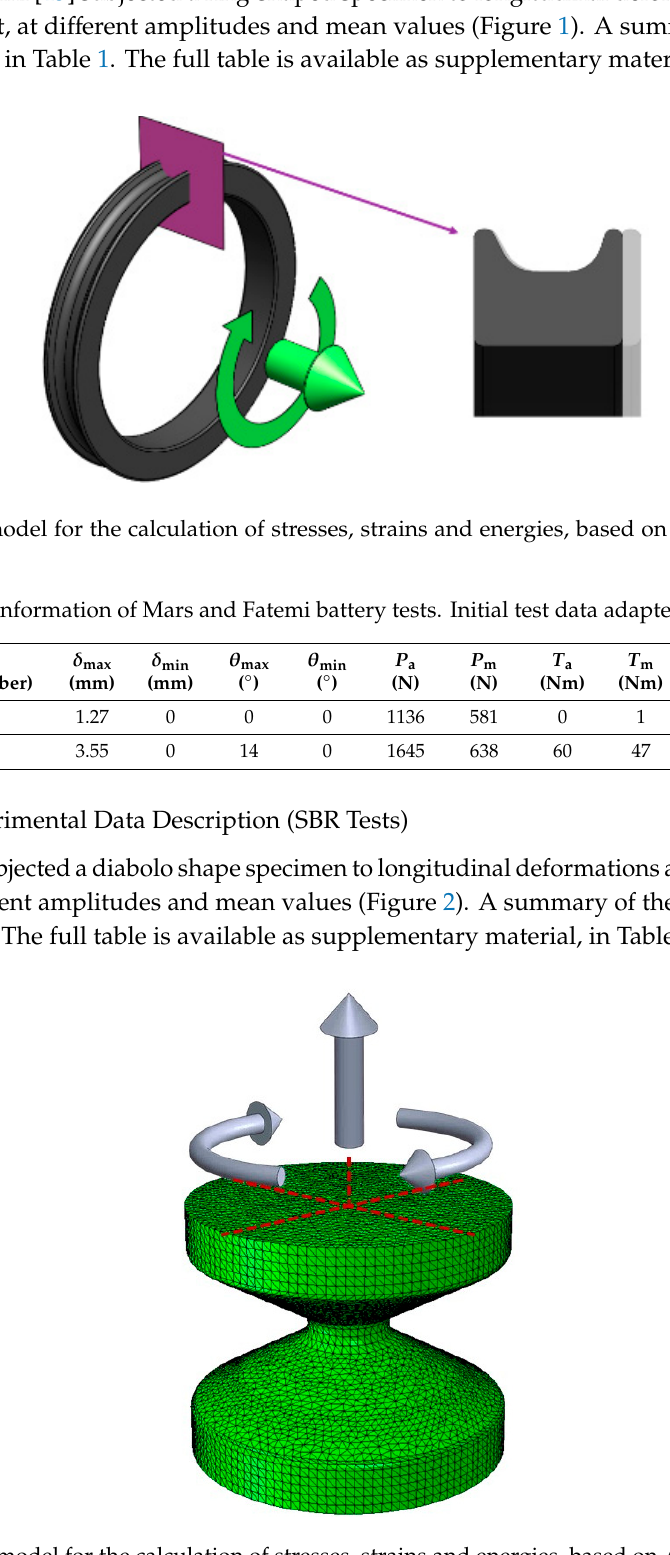
Figure 2. 3D model for the calculation of stresses, strains and energies, based on Ayoub tests [46]. Table 2. Information of the Ayoub battery tests. Initial test data adapted from [46].